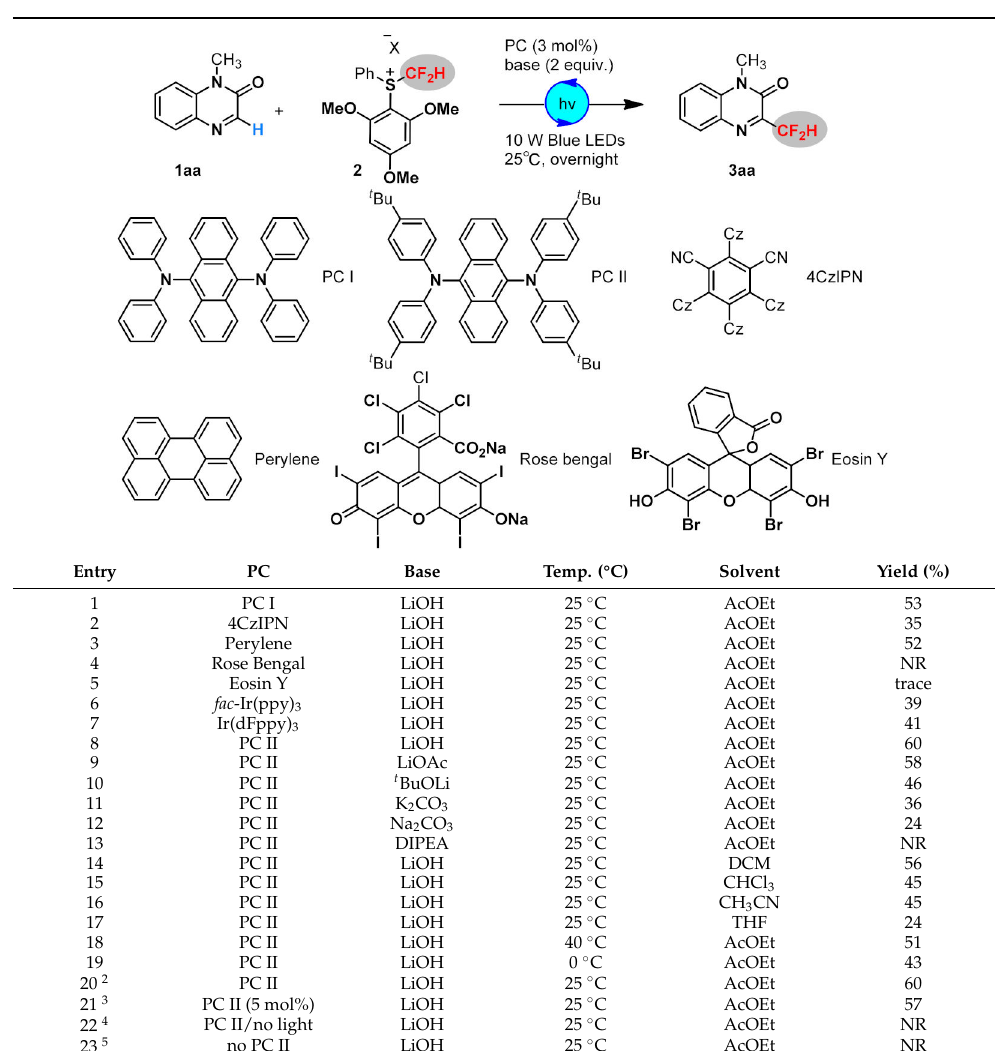
Table 1. Optimization of conditions 1